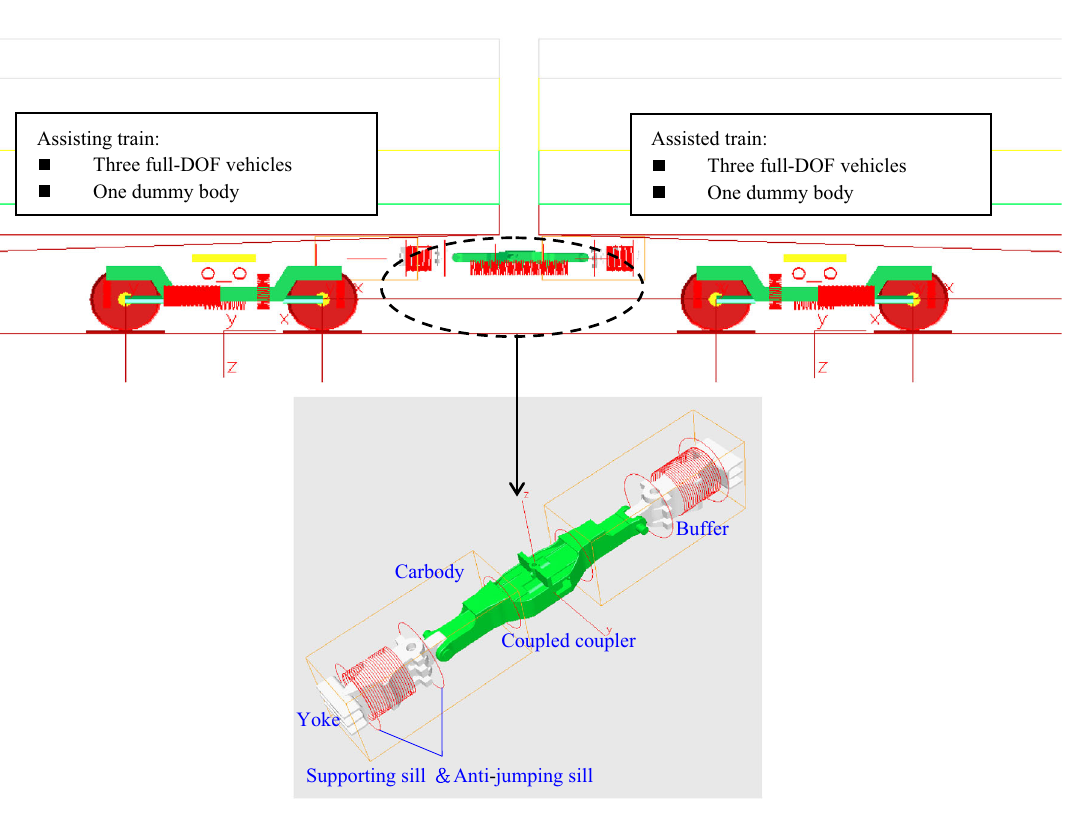
Fig. 7 Train and coupler system dynamic